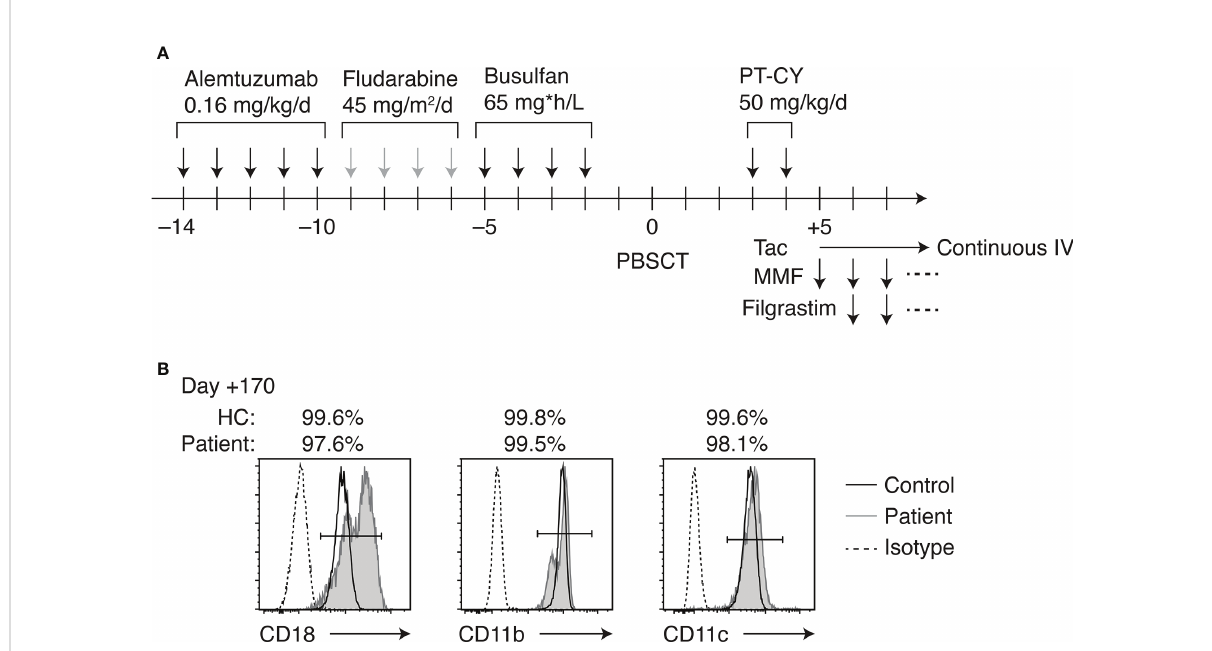
FIGURE 2 HLA-haploidentical HCT. (A) Conditioning regimen and GVHD prophylaxis. (B) Flow cytometric analysis of CD18, CD11b, and CD11c expression on peripheral blood neutrophils of the patient on day +170 of